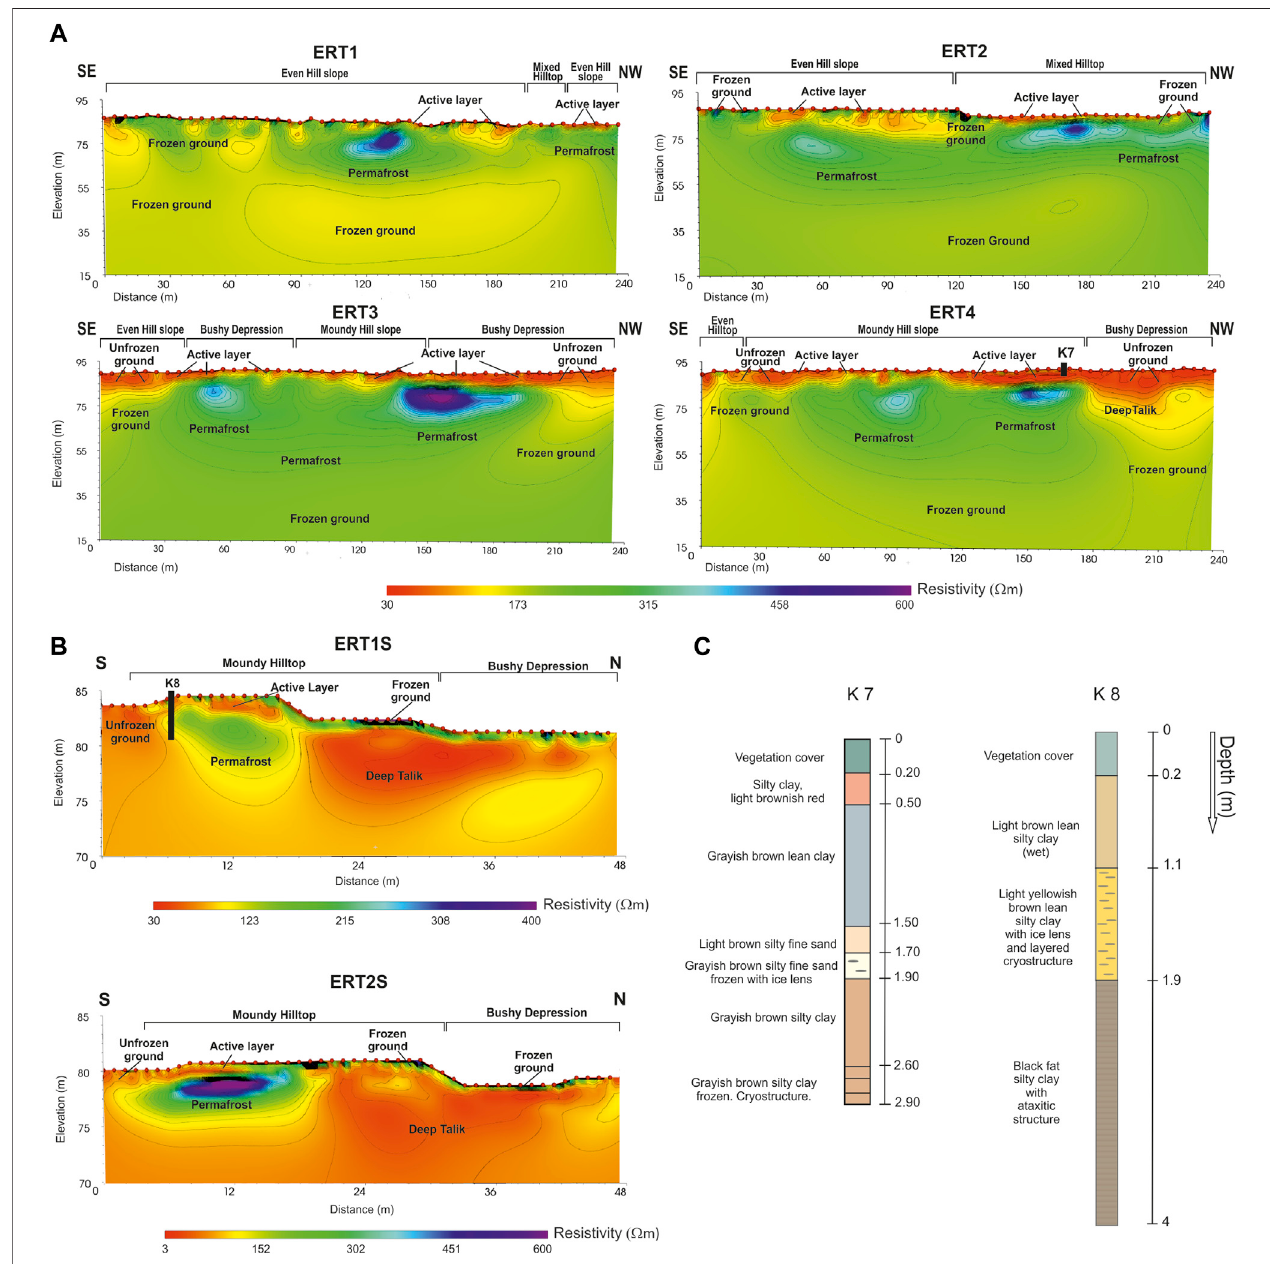
FIGURE7| ERTsectionsin (A) Site1A(ERT1,ERT2,ERT3,andERT4)andin (B) Site1B(ERT1SandERT2S).ThepositionsofboreholesK7andK8areindicated on the pro fi les ERT4 and ERT1S, respectively. The interpretation of the ERT pro fi les is based on the analyzed resistivity-cryological patterns. ERT sections exhibit a continuouspermafrostlayerwithresistivityvaluesintherange200 < ρ < 600 Ω m,underlyingalowresistivity( ρ < 100 Ω m)activelayer.Reddotsrepresenttheelectrodes deployed along the topographic surface. (C) K7 and K8 borehole stratigraphy (data from Budantseva et al., 2015; Voytenko et al., 2017). The cryolithology highlights the presence of silty clay frozen bodies with cryogenic structures in both boreholes, in agreement with the ERT results. Hence, the silty clay with an ataxitic structure at about 2 m depth in K8 produces the resistivity decrease observed in the ERT1S and ERT2S pro fi les.